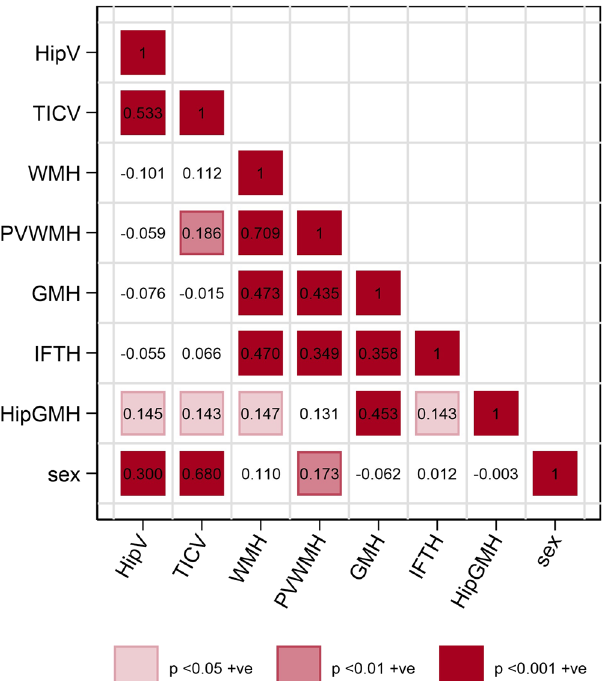
Figure 1. Correlation between hippocampal volume (HipV), total intracranial volume (TICV), number of deep white matter hyperintensities (WMH), number of periventricular white matter hyperintensities (PVWMH), number of grey matter hyperintensities (GMH), number of infratentorial hyperintensities (IFTH), number of hippocampal grey matter intensities (HipGMH) and sex at the time of baseline MRI image collection (age ~ 67–70). Colour gradients represent level of significance with most intense colour indicating the highest level of significance. Only individuals with information on sex, total intracranial volume and age are included. Created using STATA/MP version 15 (StataCorp. 2017. Stata Statistical Software: Release 15 . College Station, TX: StataCorp